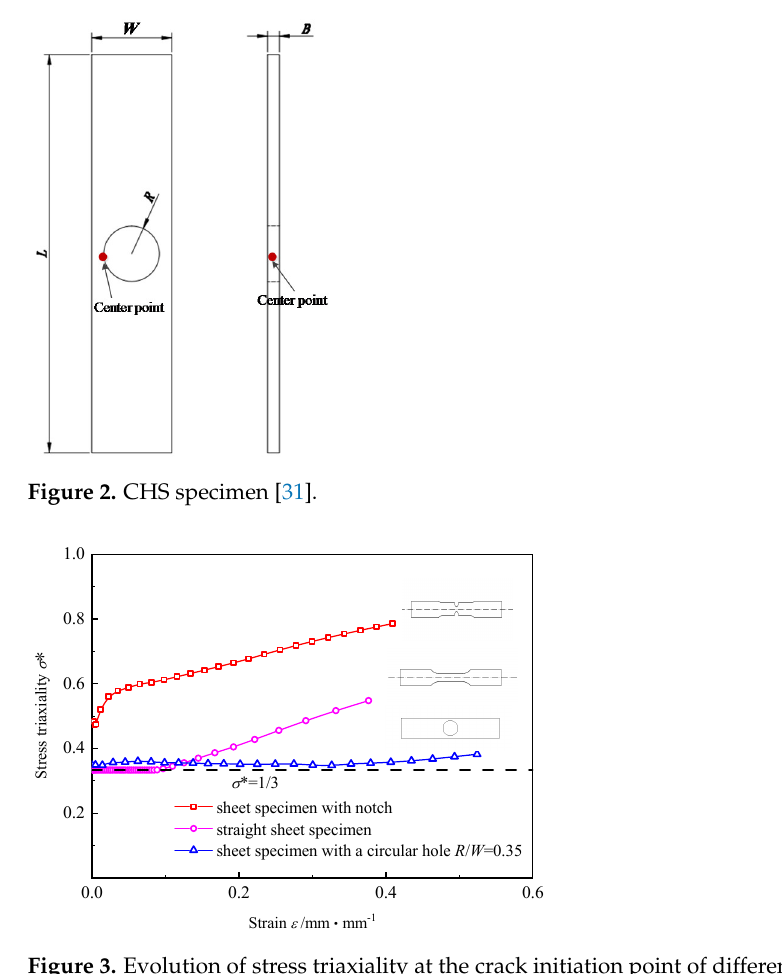
Figure 3. Evolution of stress triaxiality at the crack initiation point of different tensile specimens.